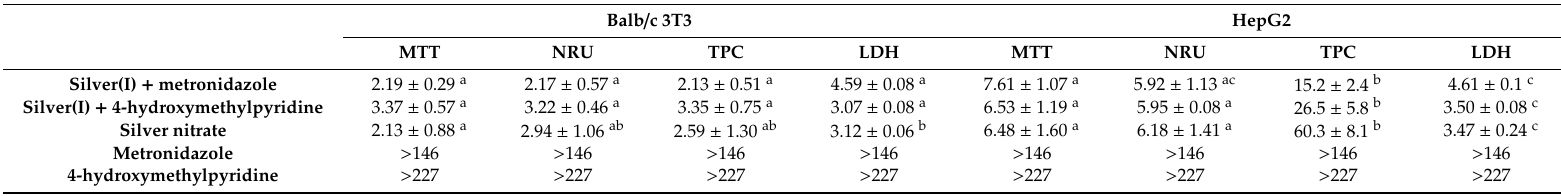
Table 1. Inhibitory concentrations (IC 50 , µ M) determined in Balb / c 3T3 and HepG2 cells by MTT, NRU, TPC, and LDH assays after 72 h exposure to study compounds; data presented as mean ( n = 3) ± SEM (standard error mean). The di ff erent superscripts (a, b, c) within a line indicate significant di ff erences between the used assay ( p ≤